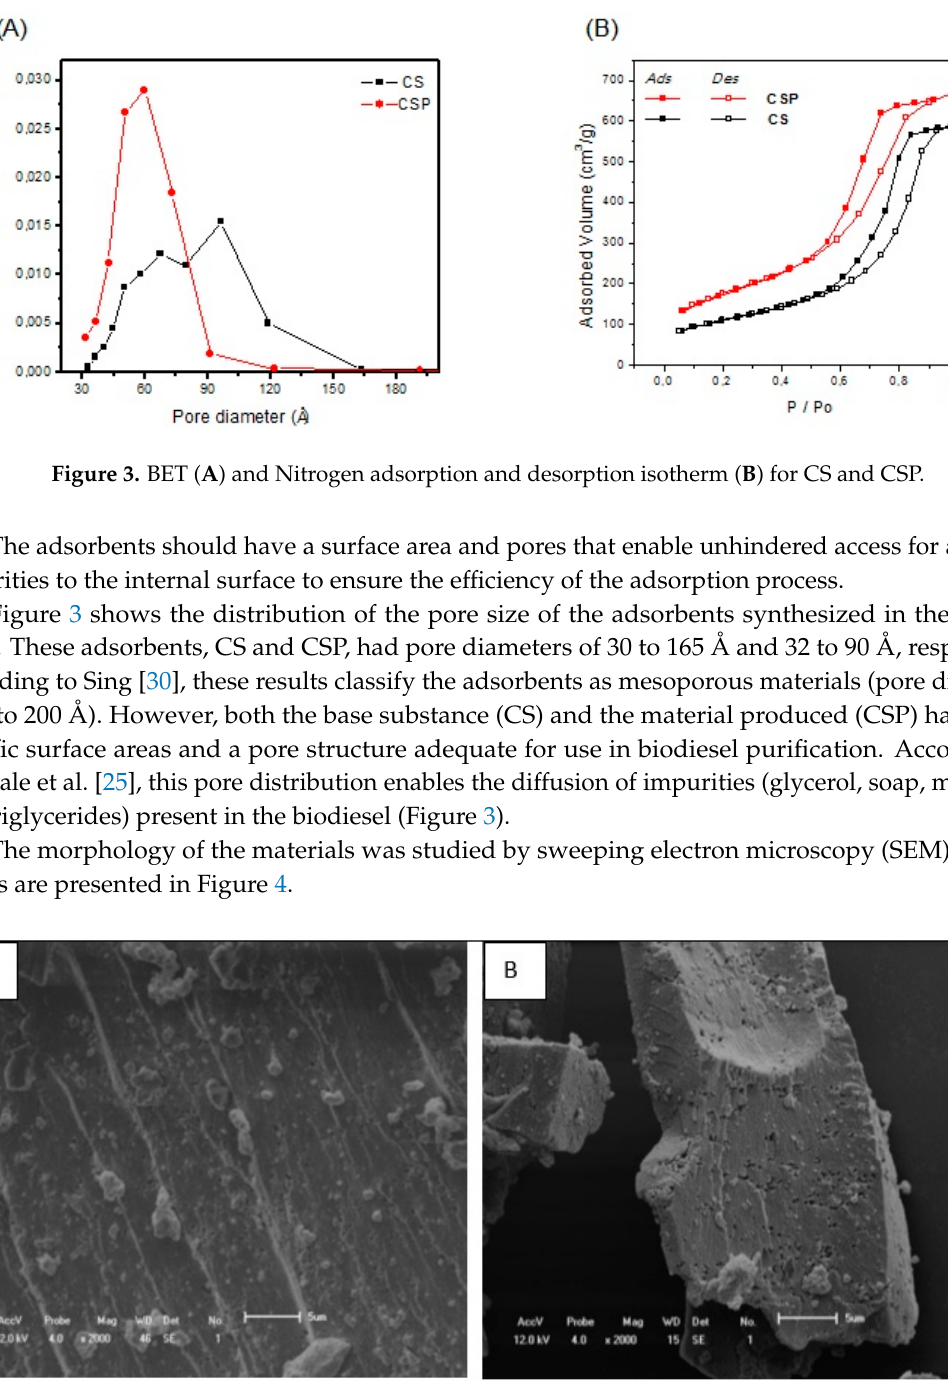
Figure 4. Scanning Electron Microscopy Images for CS ( A ) and CSP ( B ). The images are 5 micrometers with zoom of 2000×, respectively.